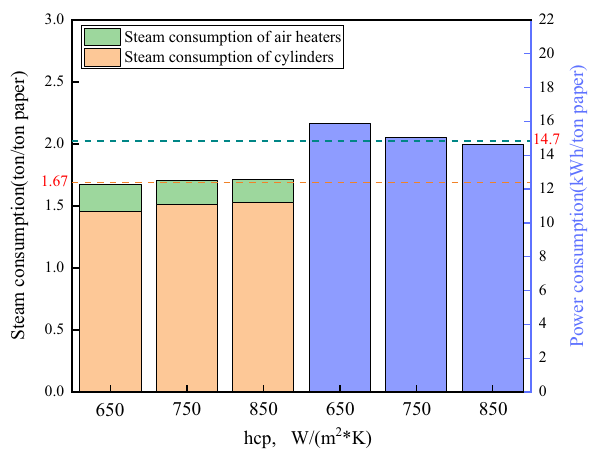
Fig. 6 Comparison of the calculated and the measured energy con- sumption